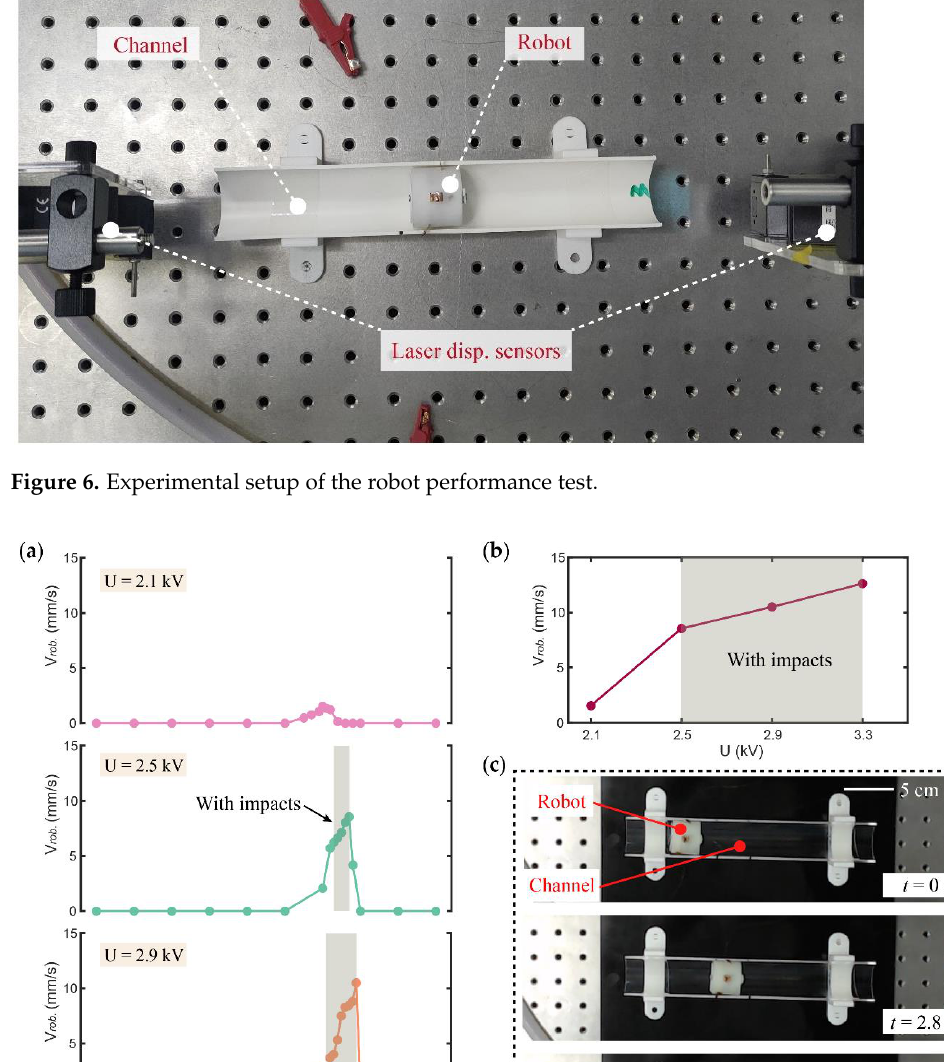
Figure 6. Experimental setup of the robot performance test.